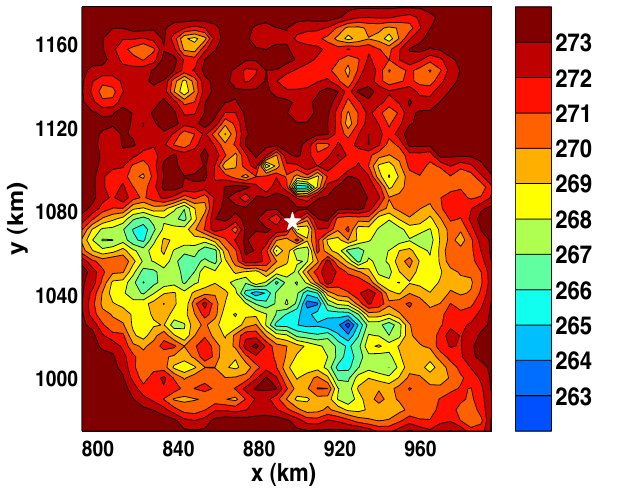
Fig. 10. Anisotropic steady-state simulation: Temperature relative to the pressure melting point at the ice base (in K, contour spac- ing 1 K). Dark red areas ( T 0 > 273 K) have a temperate base. The white star indicates the location of the Dome Fuji drill site, north is towards the top right (see Fig. 1).